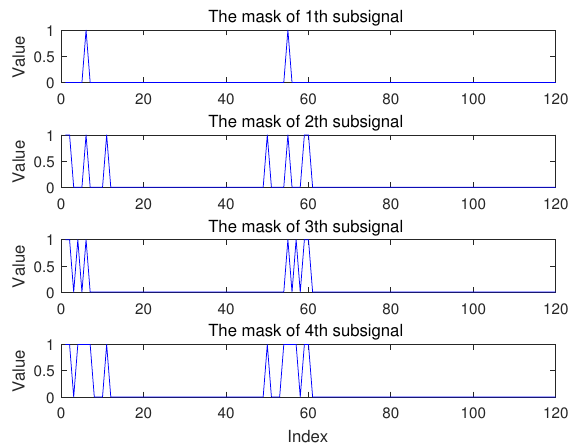
Figure 13. The mask of 4